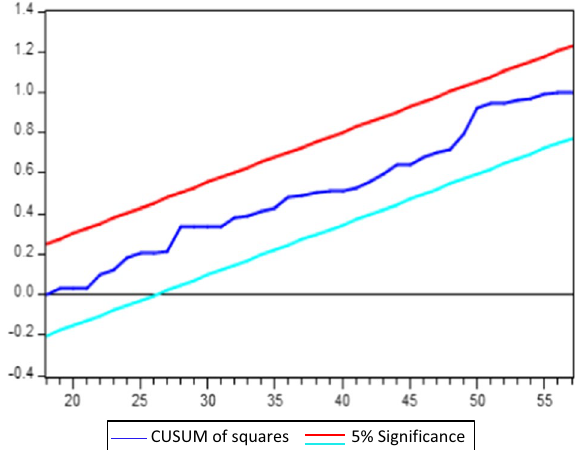
Fig. 14 Plot of cumulative sum of squares of recursive residuals